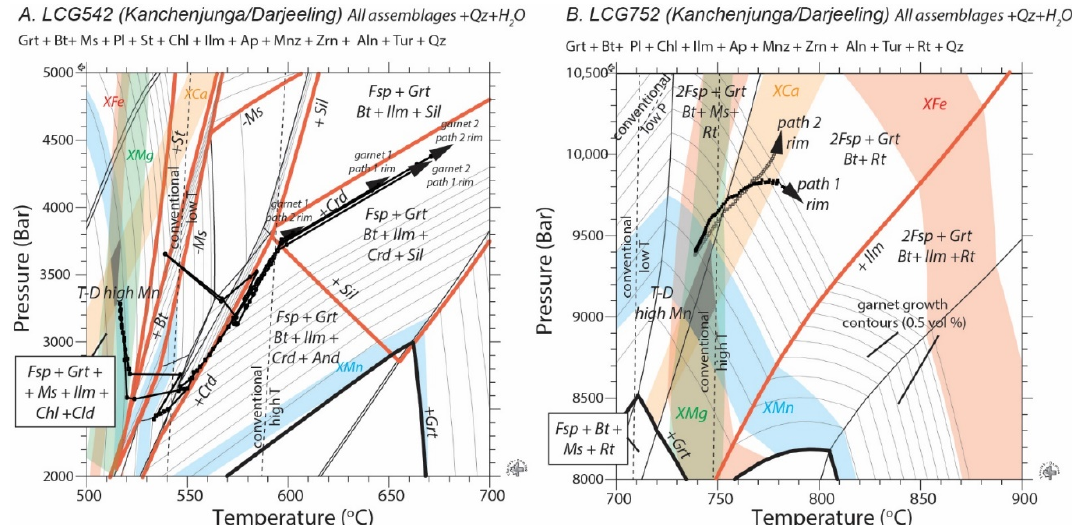
Figure 14. Isochemical phase diagrams and high-resolution P-T paths for GHC samples ( A ) LCG542 and ( B ) LCG752. In each diagram, the colored bars represent isopleths ±0.2 mole fraction of the garnet composition from the highest Mn portion of the garnet. Blue = spessartine content, green = pyrope, orange = grossular, and red = almandine. Some mineral stability fields are labeled and relevant reactions that mark the appearance of some minerals are indicated. Dashed lines are the peak T conditions estimated using conventional thermobarometry.